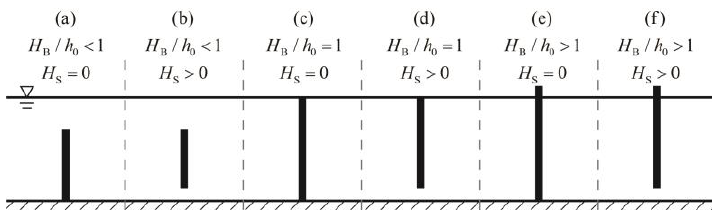
Figure 2. Various vertical baffles configurations.